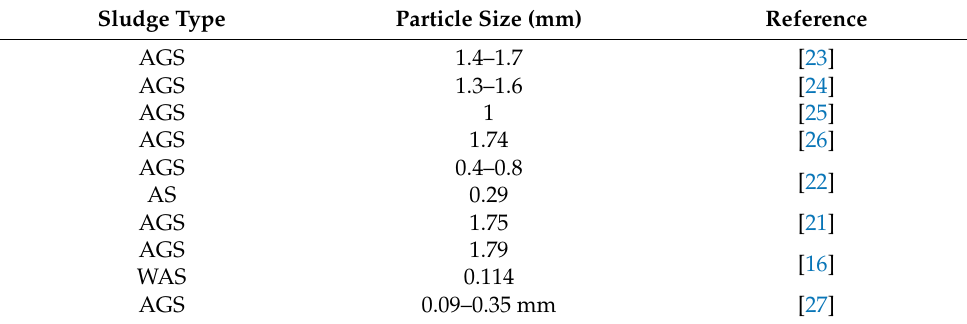
Table 1. Average particle size in AGS and AS in various